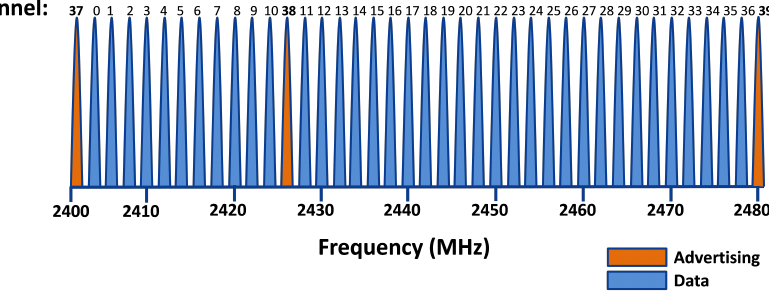
Figure 3. BLE frequency channels. It can be noticed that channels from 0–36 are assigned to data transmission in connections (blue), while the three remaining channels, from 37–39, are used as advertising channels, shown in orange. How channels are positioned in the frequency band is shown in the x -axis: the first channel, 37, is centered at frequency 2402 MHz, while the last one, the 39th, is centered at 2480 MHz. Adapted from